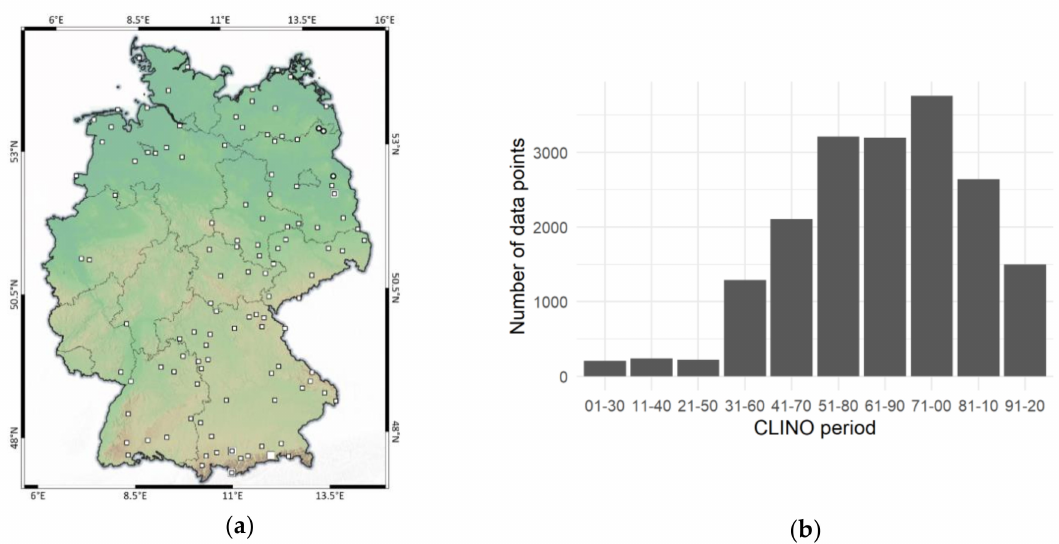
Figure 1. Overview of climate stations, ( a ) stations with less than two missing trend values between 1901 and 2019 (small rectangles), stations for a more detailed analysis (large rectangles), and stations with high-resolution data (dots), ( b ) the number of trend values per CLINO (Climate Normals)